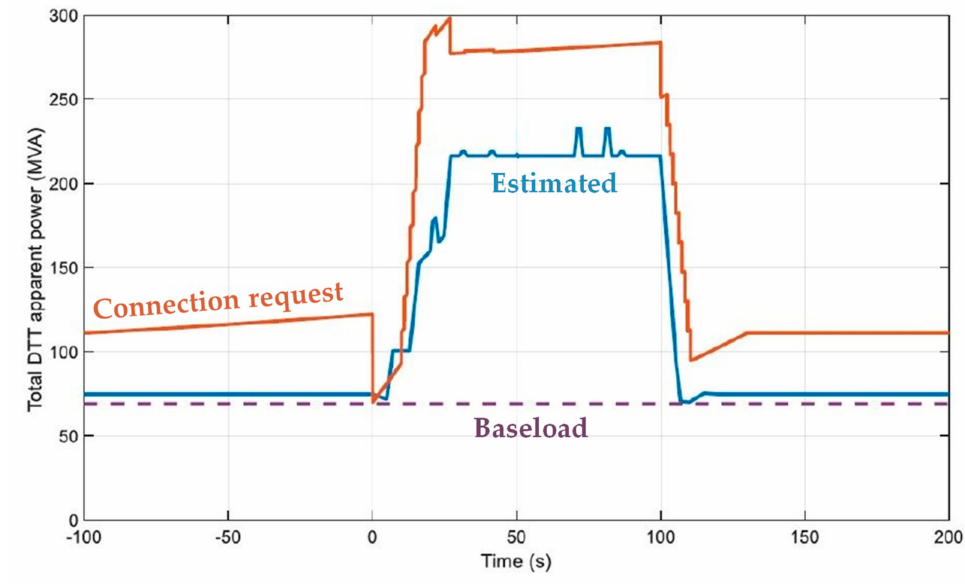
Figure 1. DTT estimated load profile compared with the connection request to the national grid. The dashed line shows the contribution of the baseload that is practically constant during the entire operation